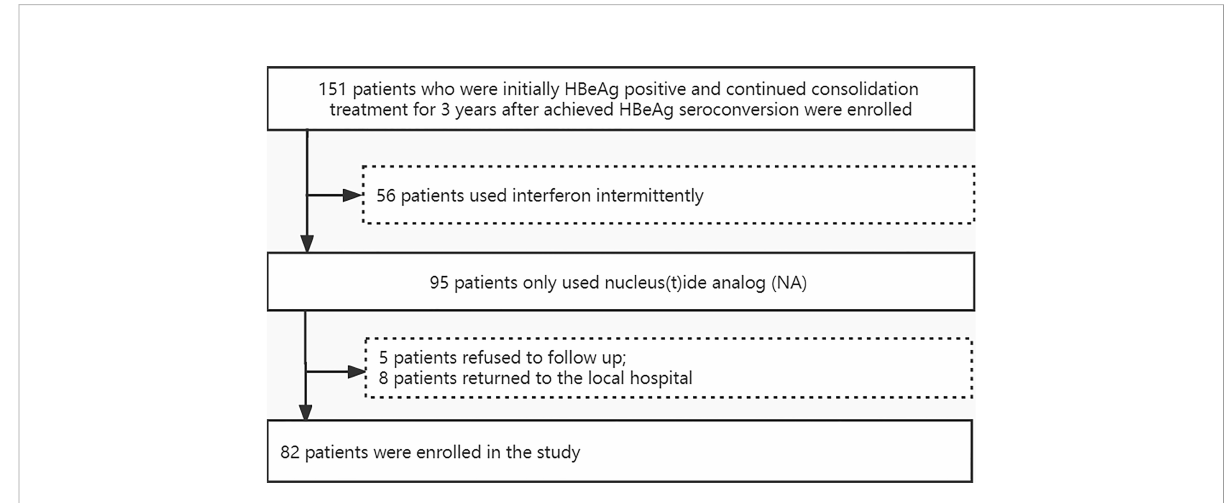
FIGURE 1 Patient enrollment and